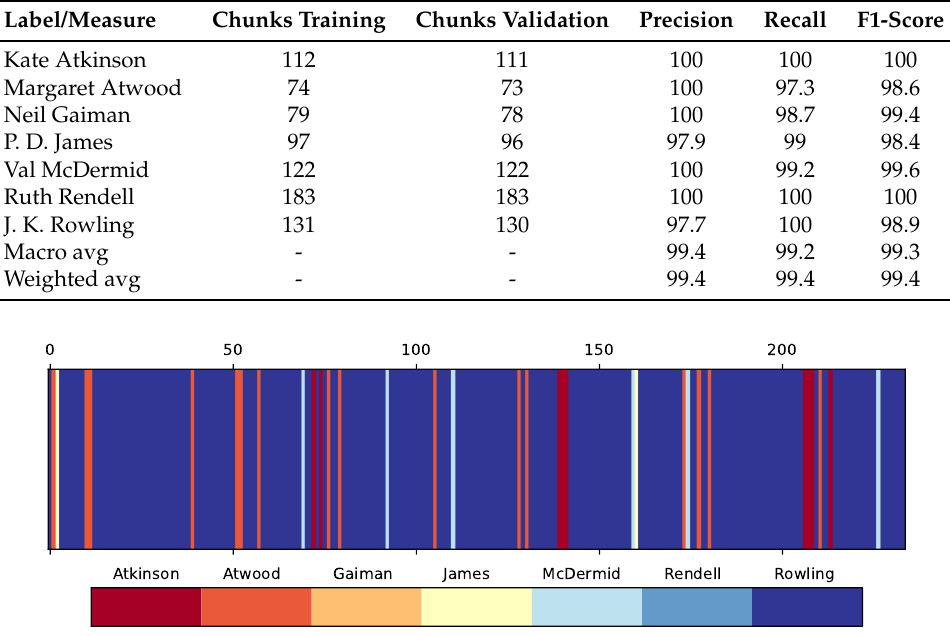
Figure 6. Classification of the 234 chunks from The Cuckoo’s Calling using the trained CGR-DL